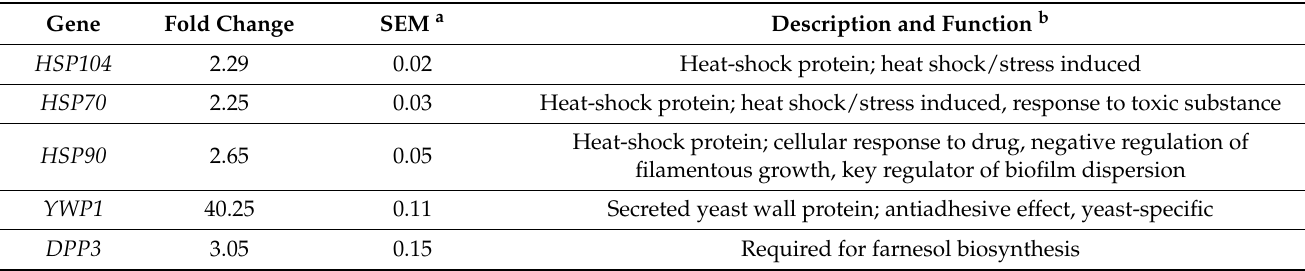
Table 2. Genes upregulated in CBD-treated C. albicans biofilm compared to their expression in untreated control as identified by real-time RT-PCR.